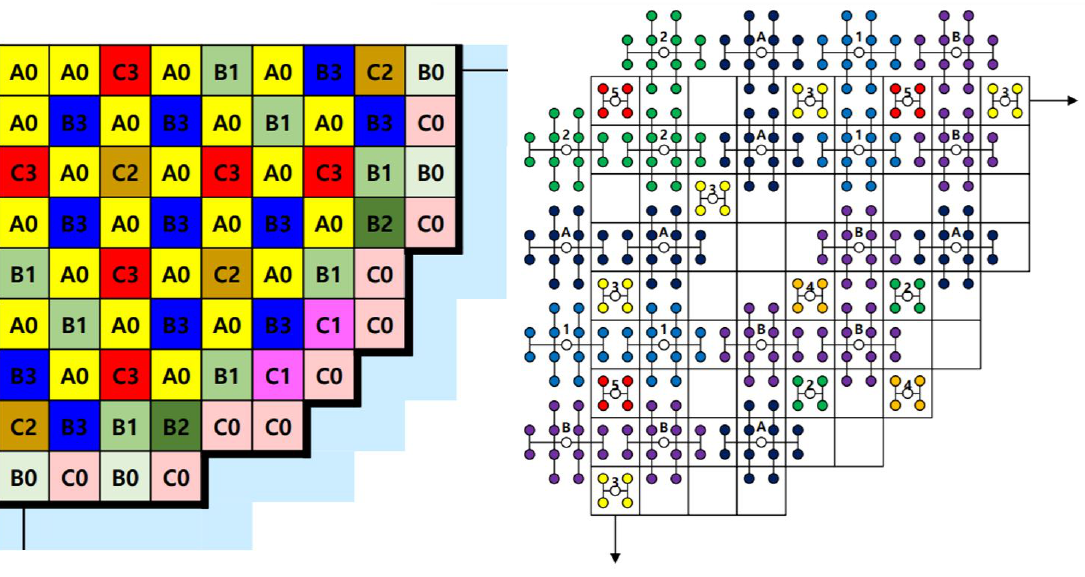
Figure 4. APR1400 Core Loading Pattern ( left ) and Control Rod Assembly Configuration ( right )